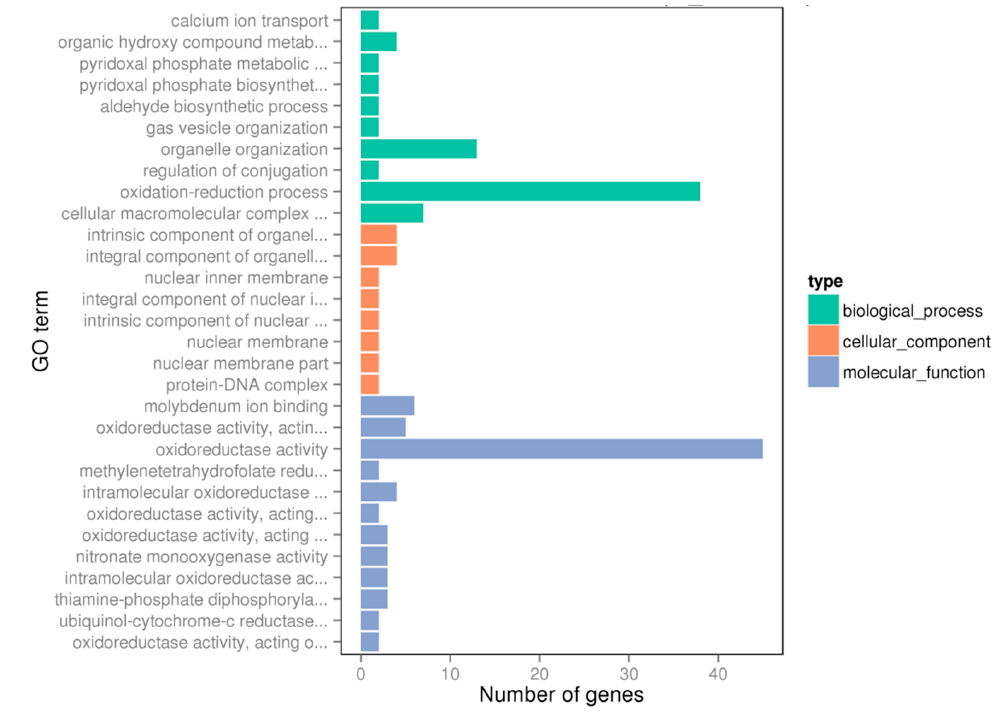
Figure 2. Functional enrichment of differentially expressed genes on gene ontology (GO) categorization. A total of 332 genes are assigned to 30 terms.